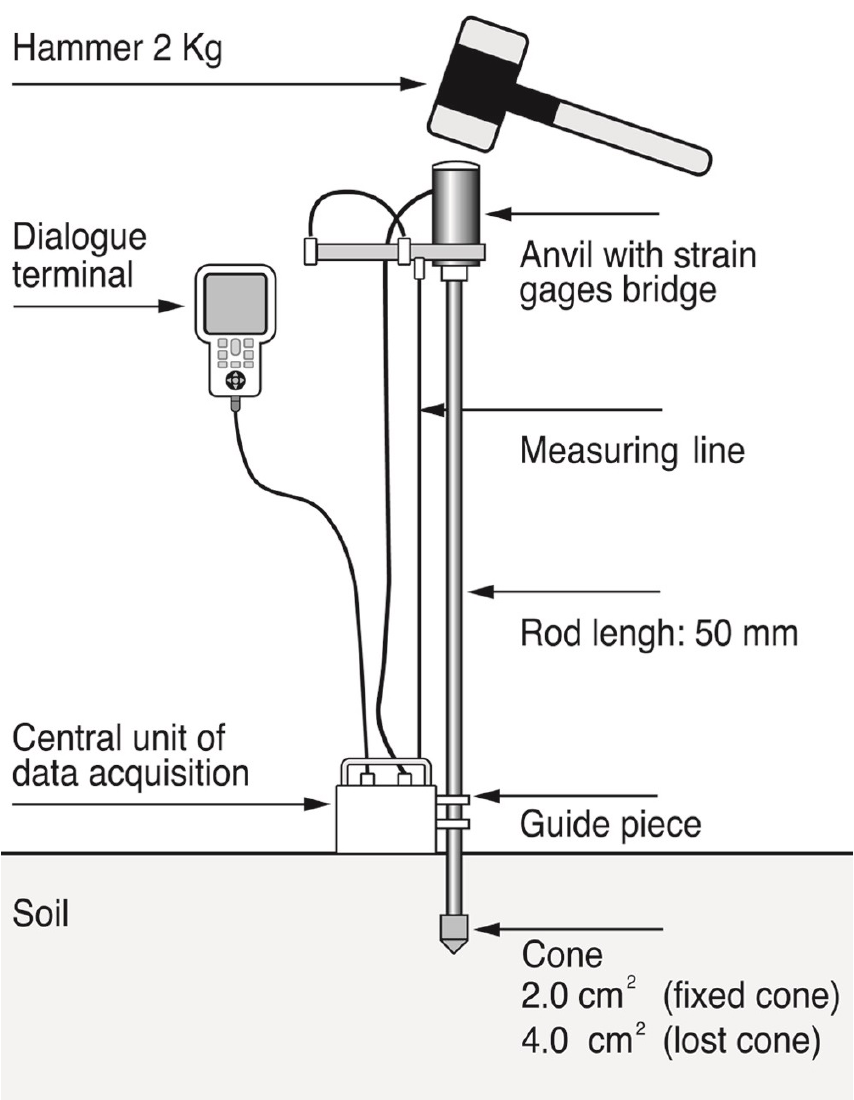
Figure 1. PANDA lightweight penetrometer scheme